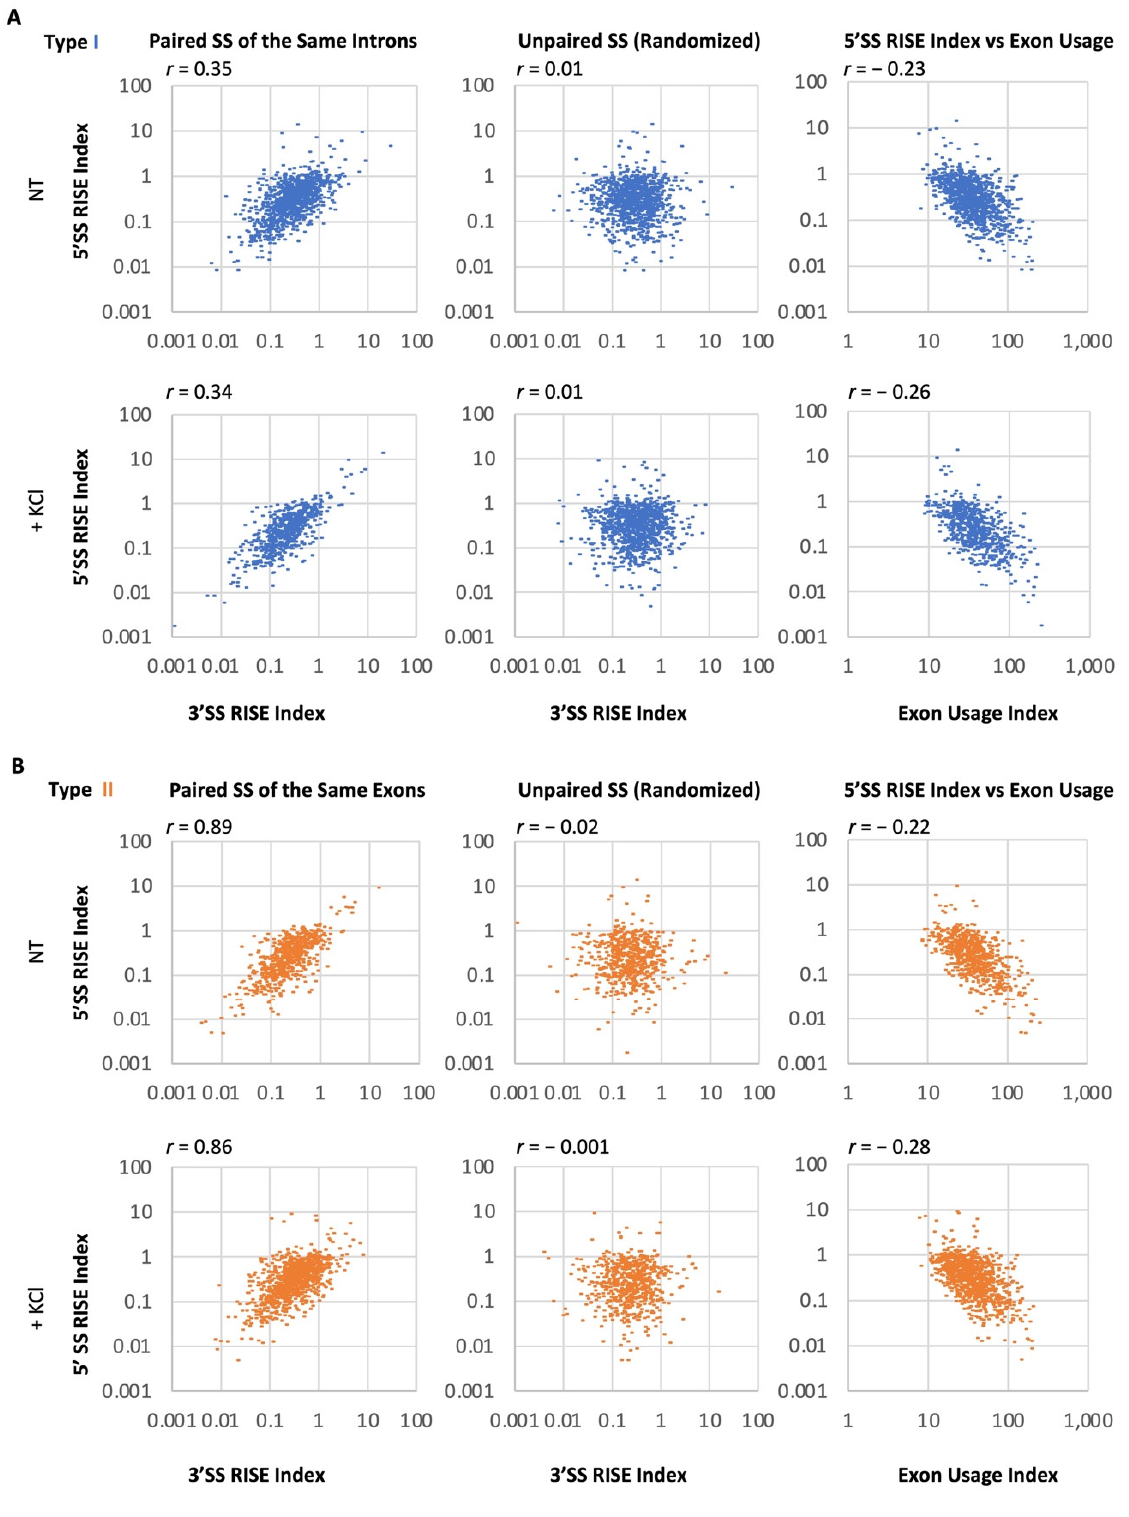
Figure 4. Transcriptome-wide correlation of RISE indexes across introns or exons. ( A ) Scatter plots of the 5 ′ and 3 ′ SS RISE indexes (Log10) across introns ( left panel), randomized ( middle ), or of 5 ′ SS RISE index versus the usage of adjacent exons ( right ), in NT ( upper ) or KCl-treated ( lower ) cells. n = 985 type I RISE. ( B ) Similarly, as in A, except across exons. n = 633 type II RISE. r : Pearson coefficient. Each index value is the mean of three samples.